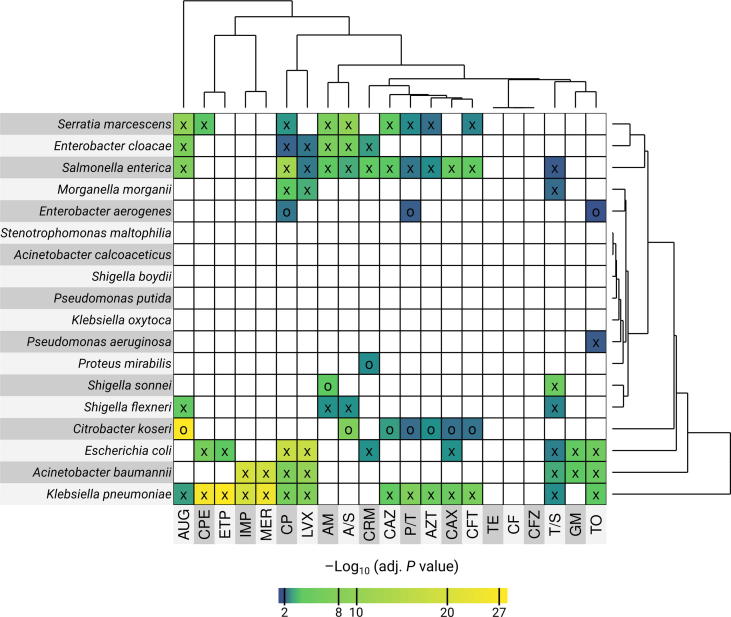
Overview of results of WMW test comparing temporal distribution of non-resistant and resistant isolates Two-sided WMW test comparing collection year distributions between non-resistant and resistant isolates. Only isolates with collection dates available from species with at least 50 isolates were included. Heatmap is coded in color gradient to indicate the negative log-transformed (base 10) FDR-adjusted P values from blue to yellow. The taxa and drugs were grouped by hierarchical clustering (Euclidean distance and average linkage on transformed P values). White cells indicate non-significant adjusted P values (≥0.01) or omitted tests (e.g., due to insufficient group size). Cases where the test estimate was below zero were marked with “x”, otherwise with “o”. FDR, false detection rate.